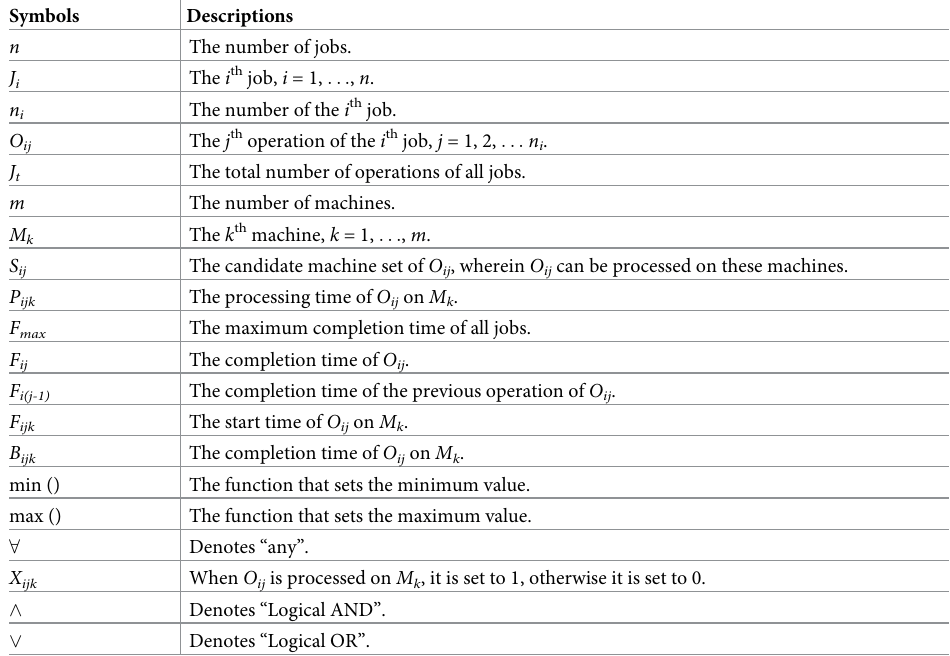
Table 3 presents an FJSP example with two jobs and five machines, wherein symbol “/” indi- cates that the corresponding operation cannot be processed on the corresponding machine.